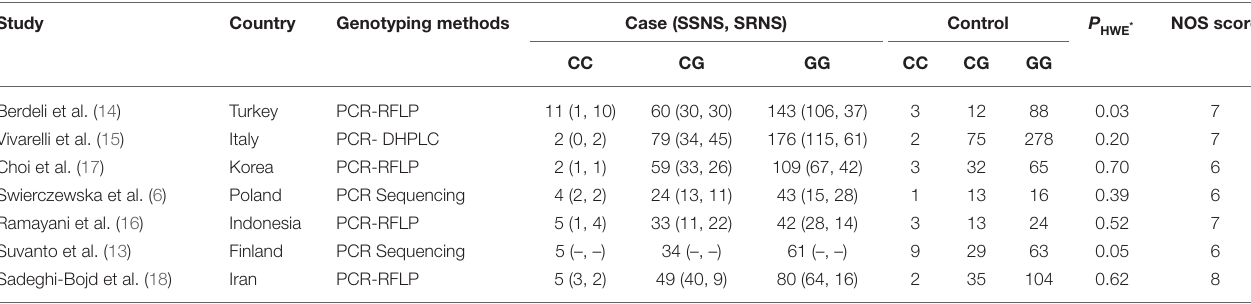
TABLE 1 | Main characteristics of eligible studies.